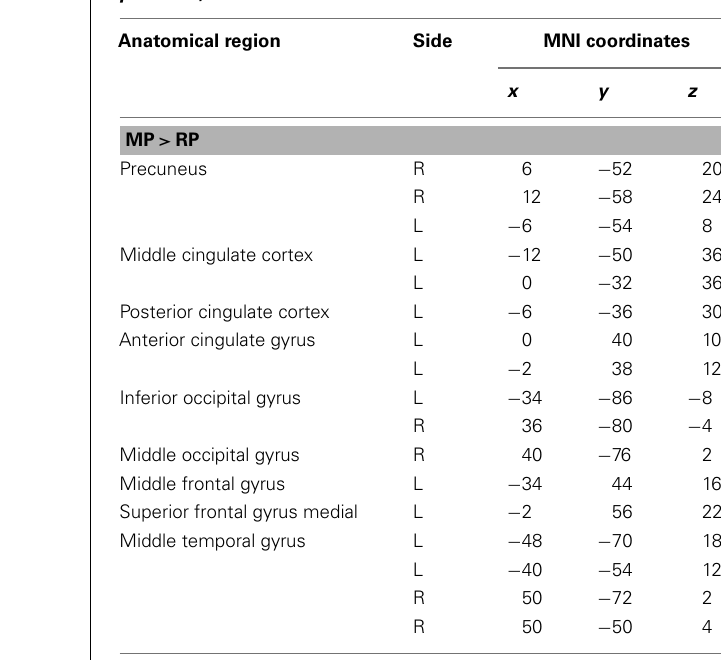
Table 4 | Group activations for the contrast between MP versus RP, p < 0.001, uncorrected.